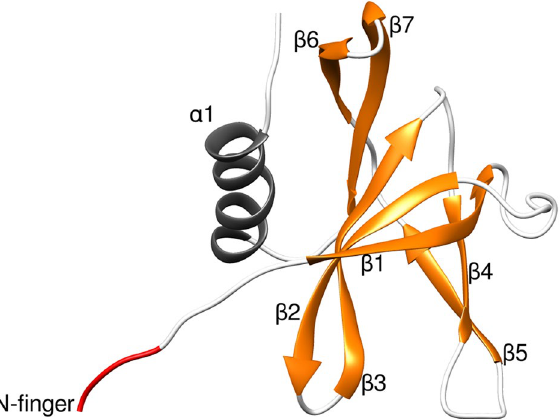
Figure 1. Representation of the monomeric unit of Nsp9. β-sheets are depicted in orange, the α-helix in gray and N-finger motif in